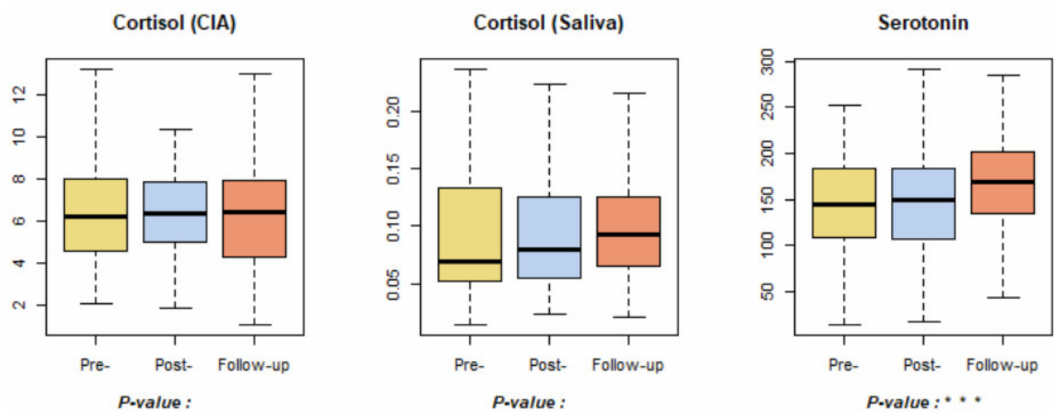
Figure 8. Results of stress (hormone)-related indicators. *** p < 0.001. Pre-: daily health conditions two weeks prior to the forest healing program; Post-: health conditions immediately after the forest healing program; Follow-up: daily health conditions one, two, and four weeks after the forest healing